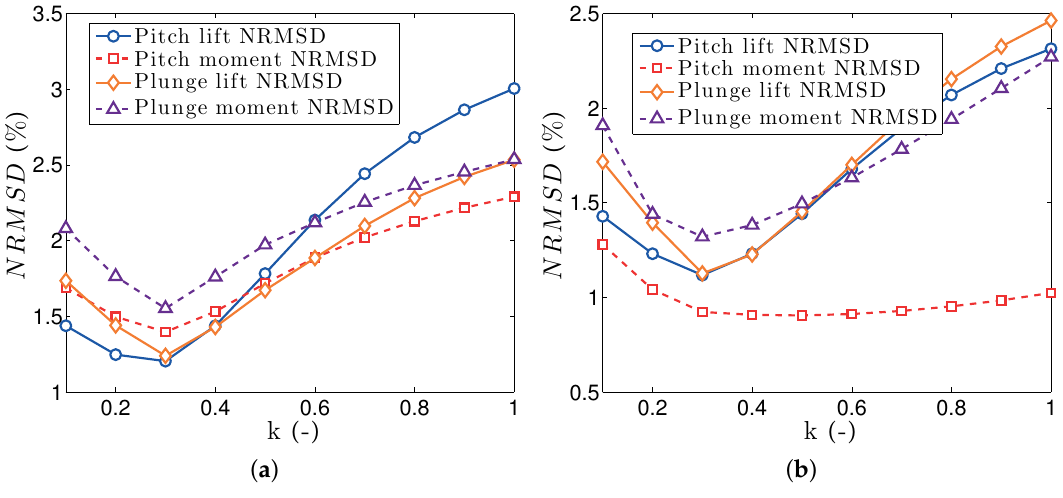
Figure 10. NRMSD between VLM and WLL aerodynamic responses for a rectangular wing AR = 6 undergoing oscillations motion. ( a ) Pitch axis on leading edge; ( b ) Pitch axis on quarter